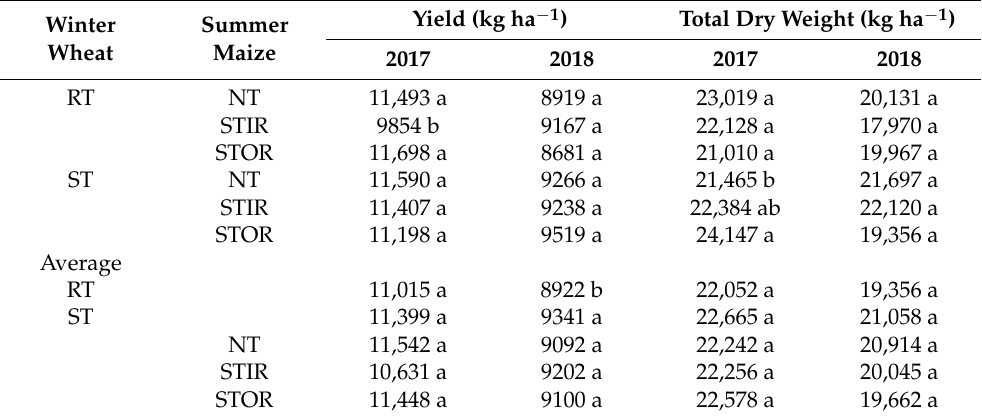
Table 2. Effects of different tillage practices on yield and total dry weight at different stages of summer maize